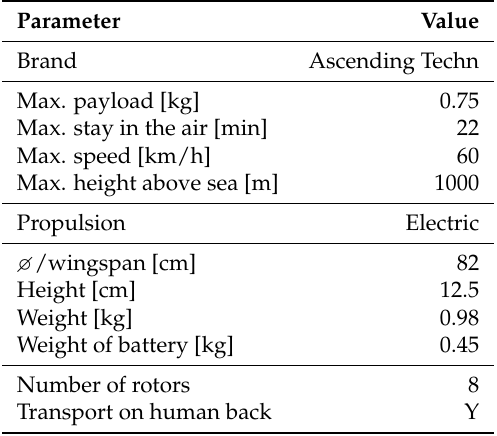
Table 2. Main characteristics of AscTec Falcon